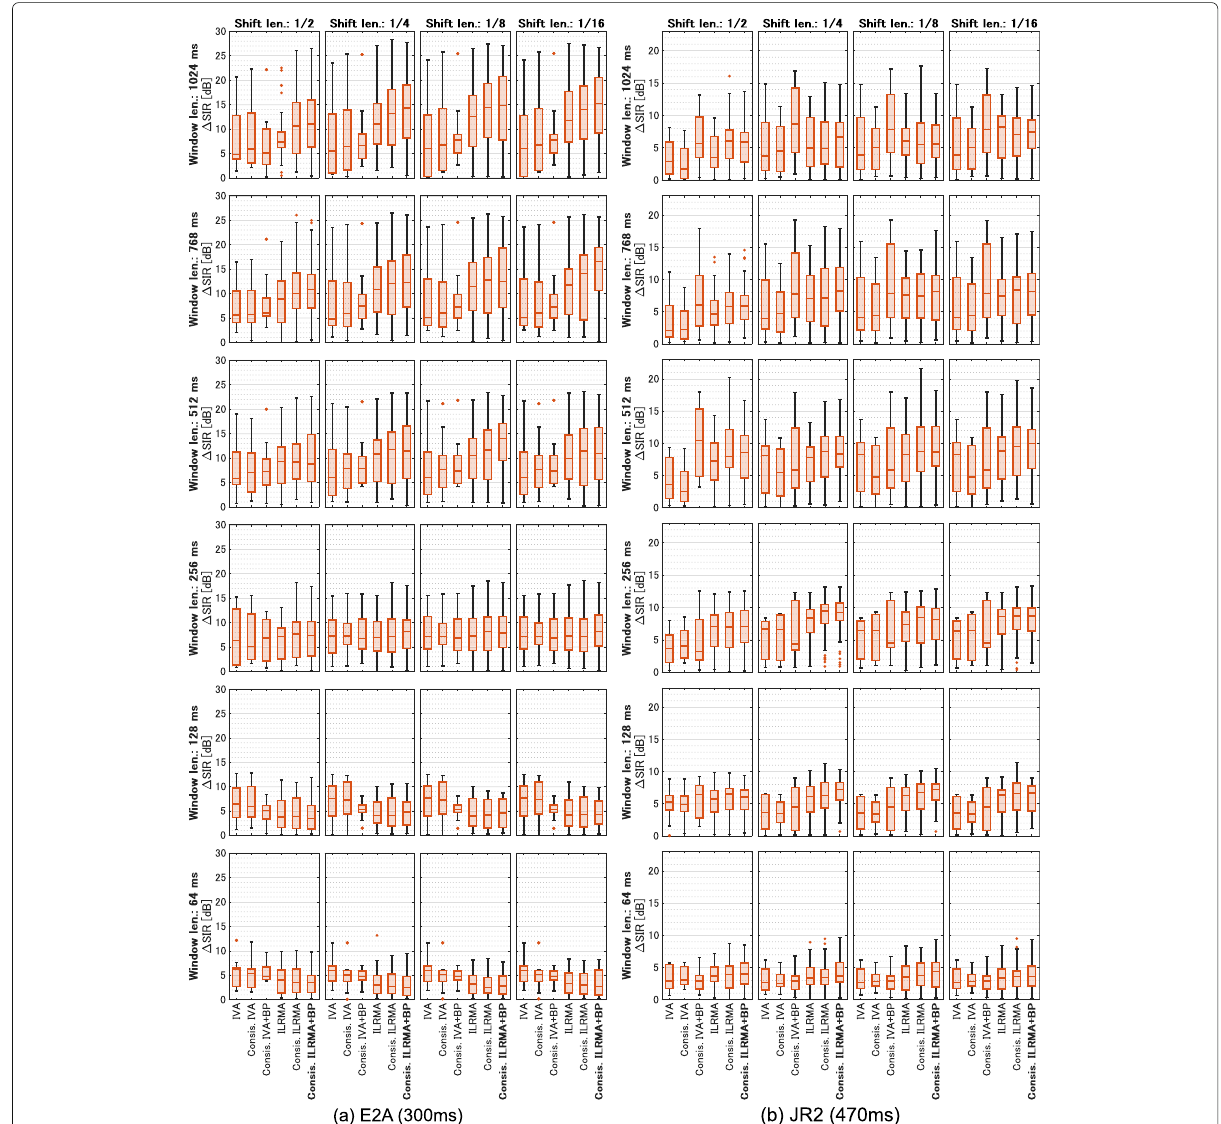
Fig. 21 Average SIR improvements for synthesized speech mixtures (speech 1–10) with a E2A and b JR2 , where Blackman window is used in